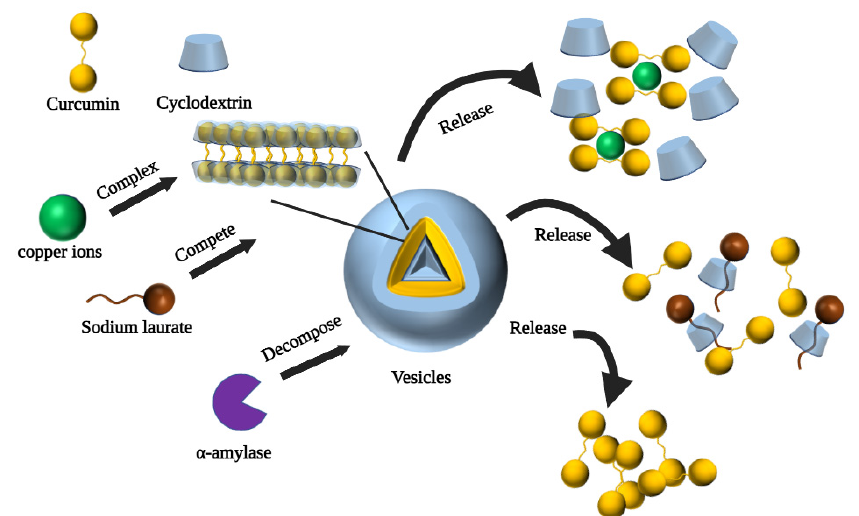
Figure 5. Mechanism of curcumin release from vesicles triggered by sodium laurate, α -amylase and copper ions [62]. copper ions